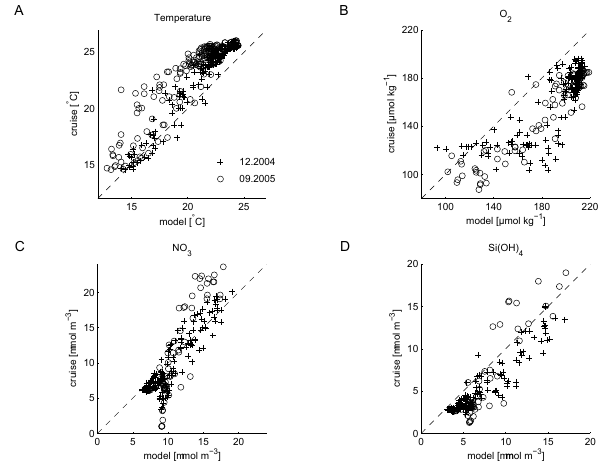
Fig. 2. Collection of scatter plots representing in situ and the mod- eled hydrographic conditions for the depth range of 0–150m and along two longitude lines (140 ◦ W and 110 ◦ W). The model results are meridional averages from 1 ◦ S–1 ◦ N, and 15-day or 9-day time averages (roughly corresponding to the length of EB04 and EB05 equatorial transects (Strutton et al., 2011)). December 2004 data (+) and September 2005 (o) are plotted separately. The dashed diagonal line in each scatter plot is the 1:1 perfect model–data fit line. (A) T ( ◦ C), (B) O 2 (µmolO 2 kg − 1 ), (C) NO 3 (mmolNm − 3 ), and (D) Si(OH) 4 (mmolSim − 3